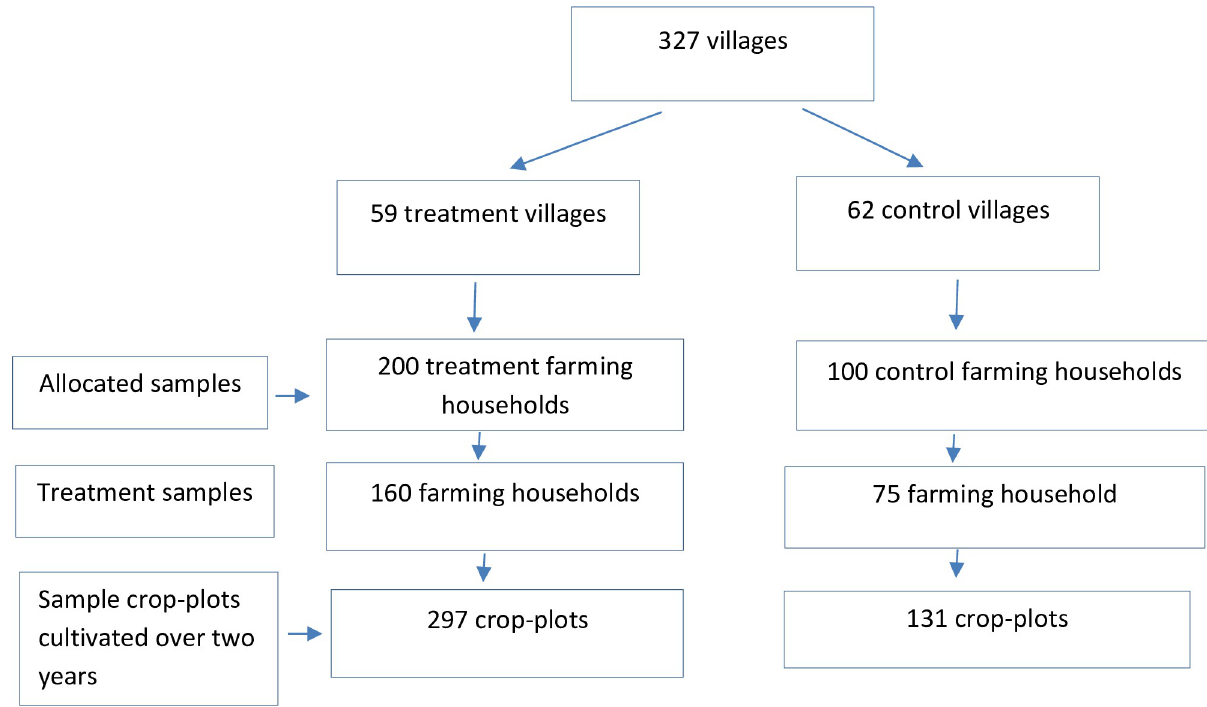
Fig 1. Experimental design. Notes: Treatment samples refer to farming households who were provided with phone numbers to access support for extension information. Due to extenuating circumstances, households were purposely oversampled by randomly selecting pigeon pea growing households at the village